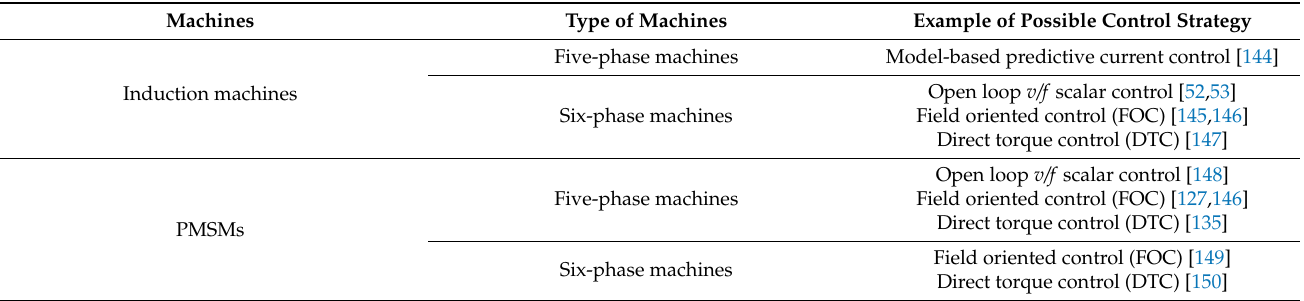
Table 5. Different possible control methods for five and six-phase